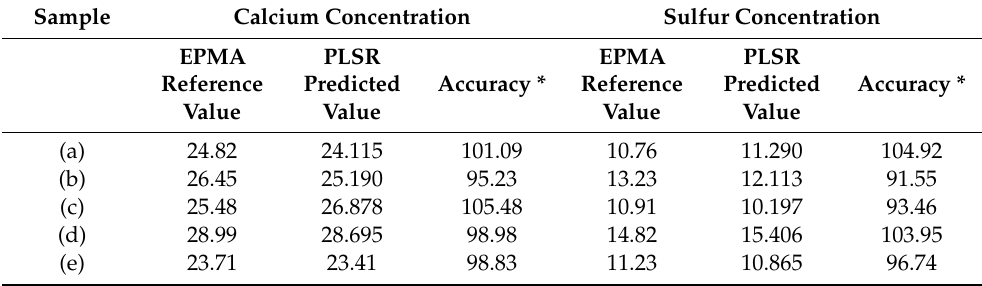
Table 3. Reference and predicted values of calcium and sulfur in analyzed gypsum samples. (a) Gypsum, Kachchh, Gujarat; (b) Gypsum, Rajpura-Dariba Cu-Pb-Zn Mine, Rajasthan; (c) Gypsum, Rajpura-Dariba Cu-Pb-Zn Mine, Rajasthan; (d) Acicular Gypsum, Morocco; and (e) Desert Rose Gypsum, Sahara Desert, Morocco.